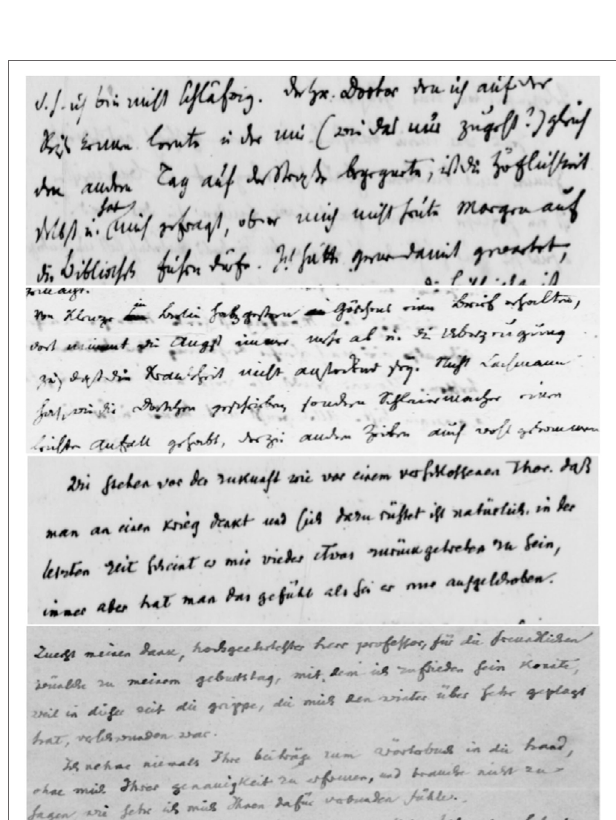
FigUre 2 | Four letters written by Wilhelm Grimm. From top to bottom: very low readability (Br 5993, 7 years old); low readability (Br 2680, 45 years old); medium readability (Br 2743, 73 years old); high readability (Br 2736, 69 years old) [Images reproduced with permission of the Hessisches Staatsarchiv Marburg].